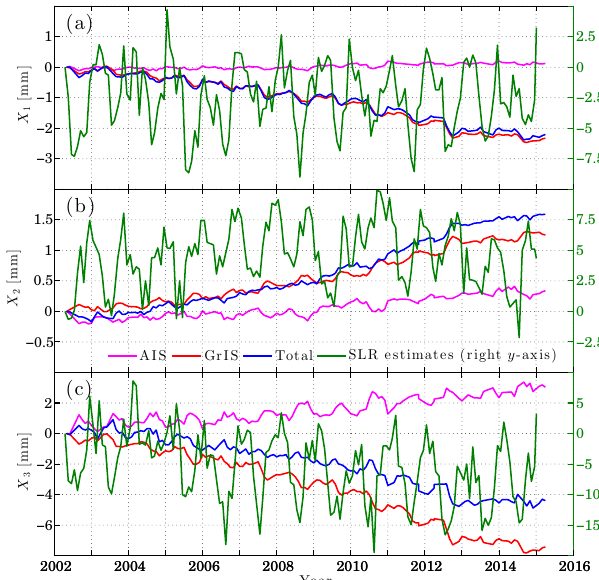
Figure 7. Geocentric motion during the GRACE period. The CM- CF shift, with respect to the April 2002 position, along the (a) x 1 , (b) x 2 , and (c) x 3 directions in a right-handed Cartesian system. (See Fig. 6d for a positive sense of horizontal axes; the vertical axis, x 3 , is positive out of the North Pole.) Note that different scales are used (in the right y axis) for the SLR-based estimates (Cheng et al.,